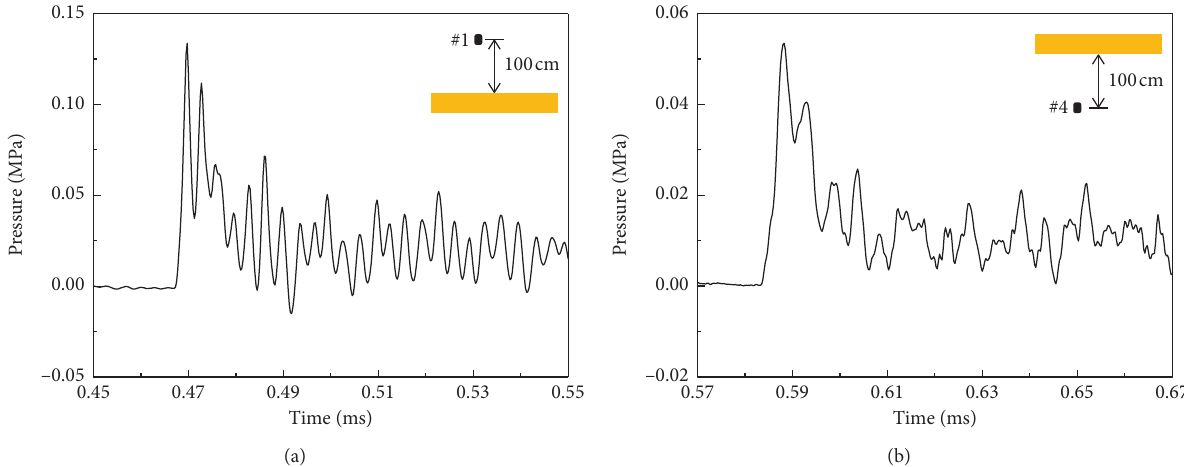
Figure 9: Time history curves of air shock wave pressure of A0. Air shock wave measured using (a) sensor #1 and (b) sensor #4.